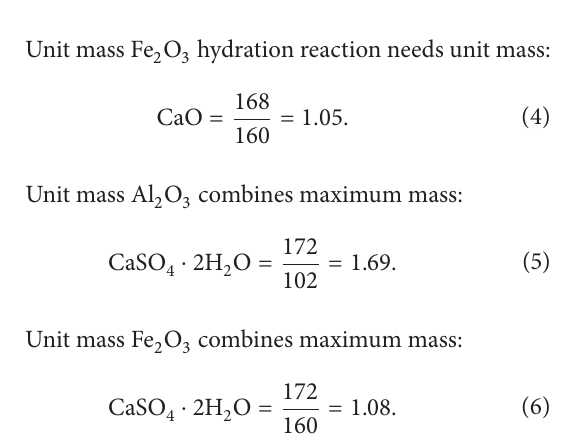
Table 3: Stabilizer components and stabilized soil strength. CFBC ash Mixture